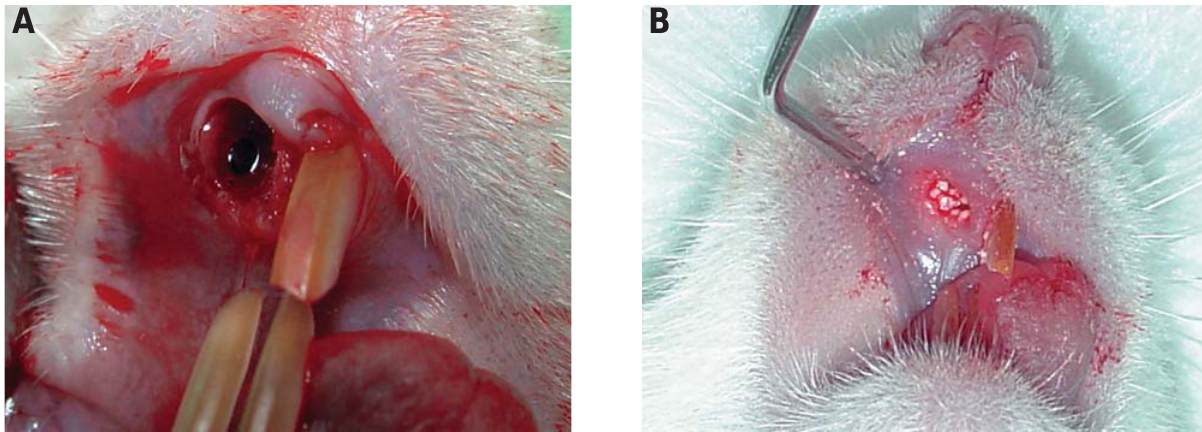
Figure 3- Surgical procedures for biomaterials implantation: A: The maxillary right incisor was extracted, and B: The socket